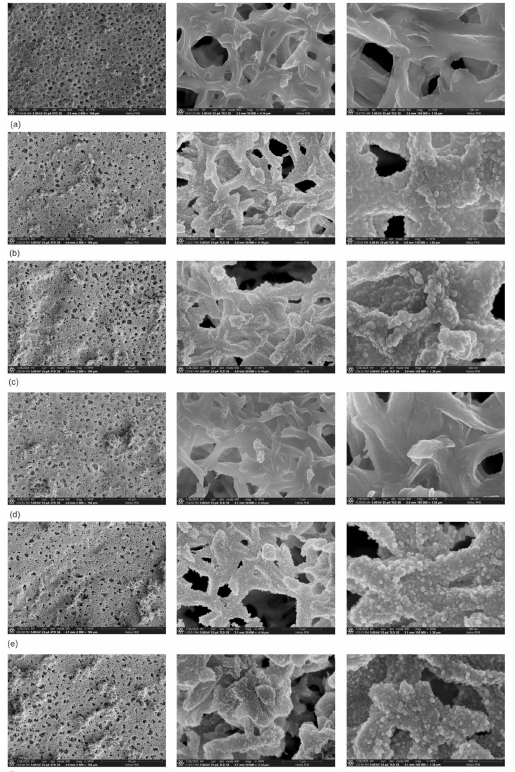
Figure 1. SEM images of the non-coated membrane ( a ) and with Zn, ZnO, and Zn/ZnO coat- ings deposited at different magnetron power sources (PM): ( b ) P M-Zn = 250 W, ( c ) P M-Zn = 300 W, ( d ) P M-ZnO = 250 W, ( e ) P M-Zn = 250 and P M-ZnO = 250 W, and ( f ) P M-Zn = 300 and P M-ZnO = 250